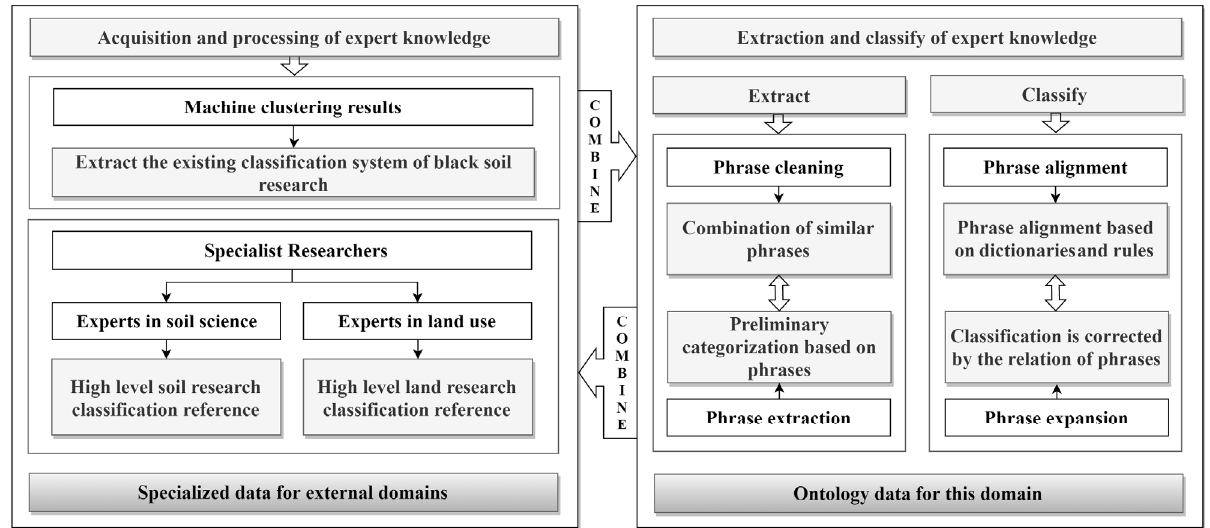
Figure 2. Expert knowledge workflow fusion research on land use in black soil areas. It combines external domain professional data with ontology data within the domain. external domain professional data with ontology data within the